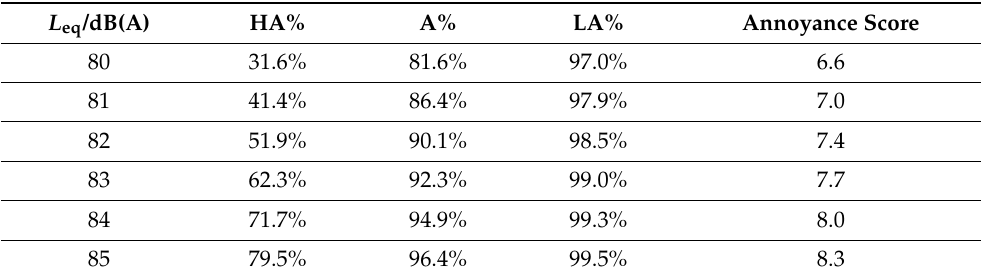
Table 4. Annoyance percentage and annoyance score corresponding to 80–85 dB(A) according to the fitting results of group A.